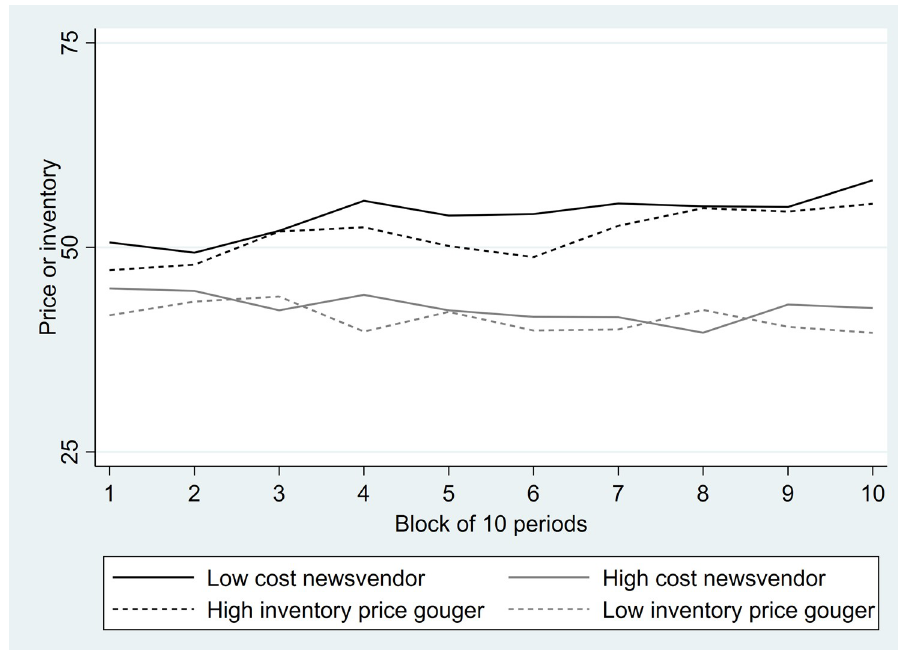
Fig 2. Inventory and pricing decisions over the